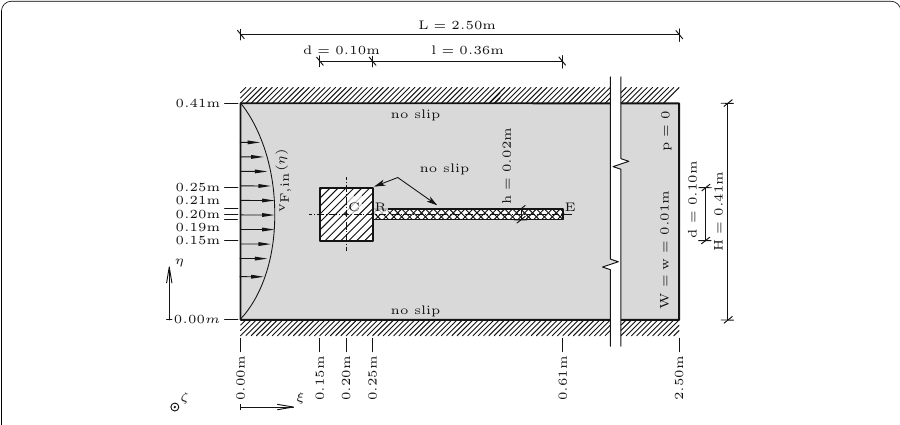
Fig. 5 Dimensions and boundary conditions of the numerical FSCI